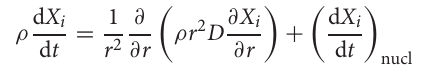
(cid:127) the mean angular velocity at radius r , U ( r ) the radial with ¯ component of the meridional circulation, and D (cid:127) the diffusion coefficient corresponding to the various diffusive processes transporting (cid:127) , like shear mixing or